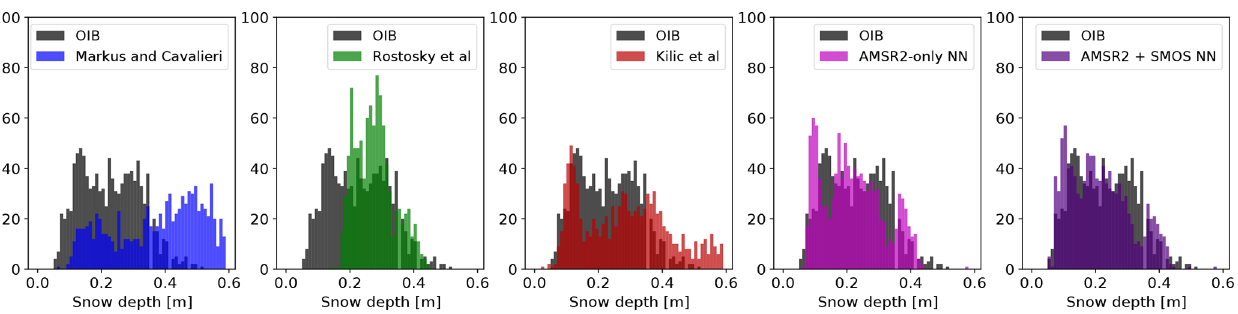
Figure 5. Distribution of OIB-measured snow depth (all data) in grey versus estimated snow depth using different algorithms in colour.